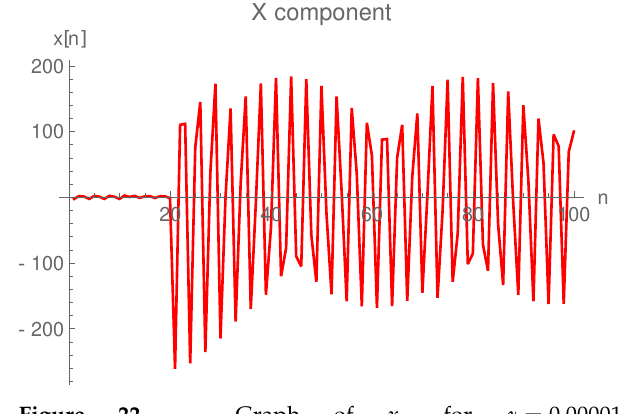
Figure 22. Graph of x n for α = 0.00001, β = 2.0, γ = 3.0, δ = 4.0, ζ = 0.00005, η = 6.0, µ = 7.0, ε = 0.00009, υ = 8.0, ρ = 10.0, σ = 11.0, ω = 12.0. with initial conditions x 0 = 1.0, y 0 = 2.0 and z 0 = 3.0.